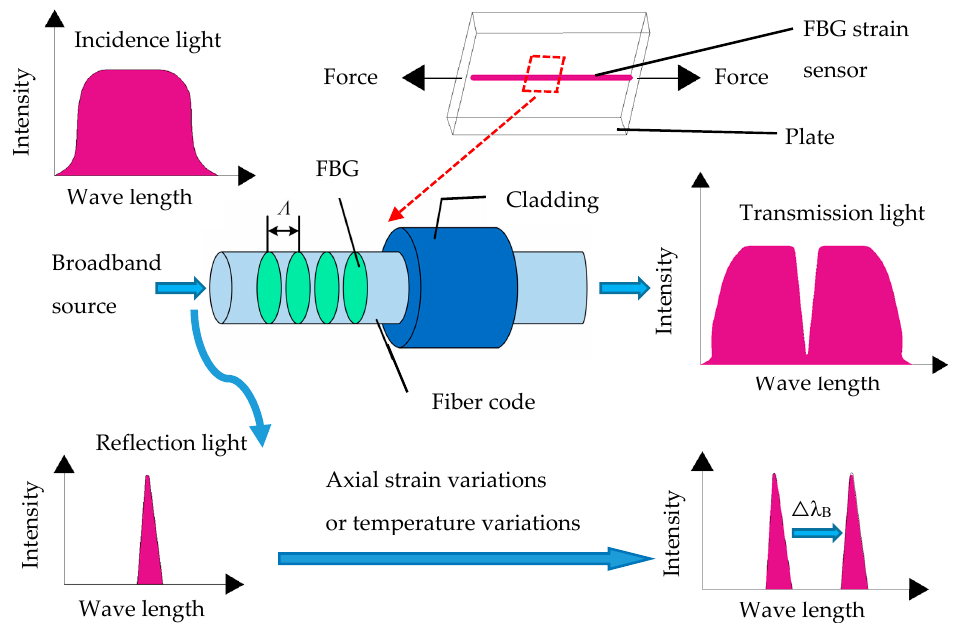
Figure 4. Schematic diagram of working principle of Fiber Bragg Grating (FBG).